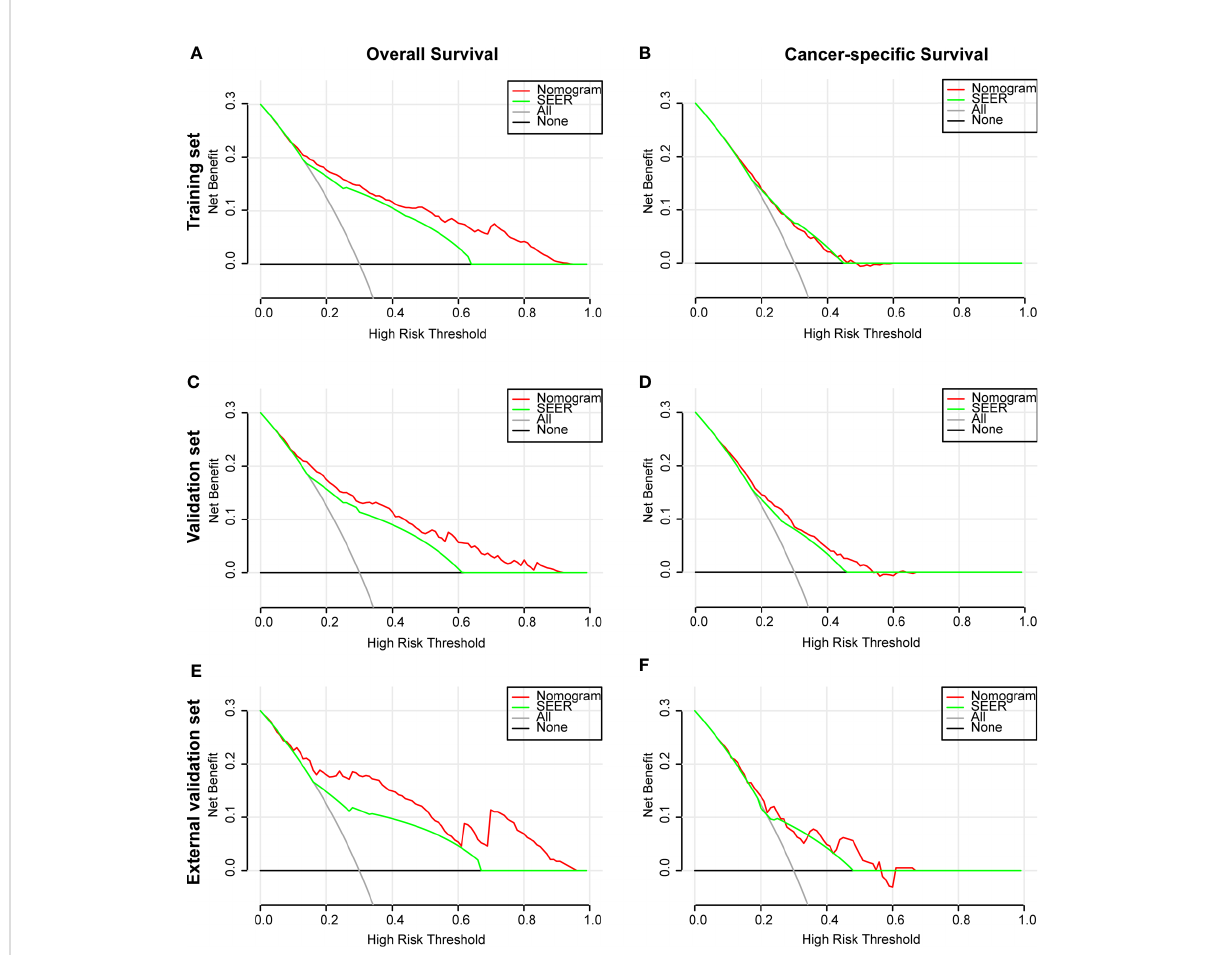
FIGURE 5 Decision curve analysis (DCA) based on nomograms and SEER stage. (A) DCA of OS for patients in the training set. (B) DCA of CSS for patients in the training set. (C) DCA of OS for patients in the validation set. (D) DCA of CSS for patients in the validation set. (E) DCA of OS for patients in the external validation set. (F) DCA of CSS for patients in the external validation